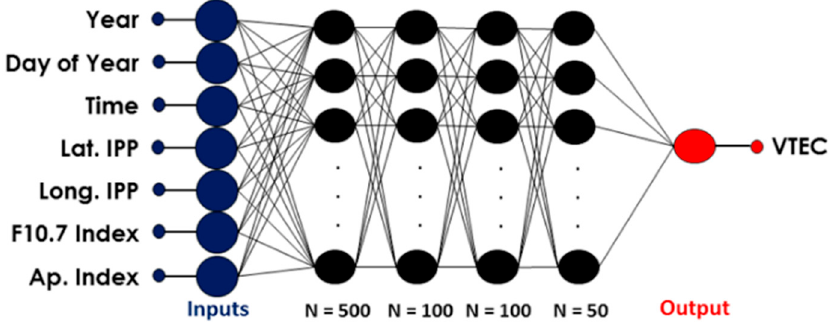
Figure 2. Multilayer perceptron neural network (MLP-NN) architecture for TEC prediction across Brazil.